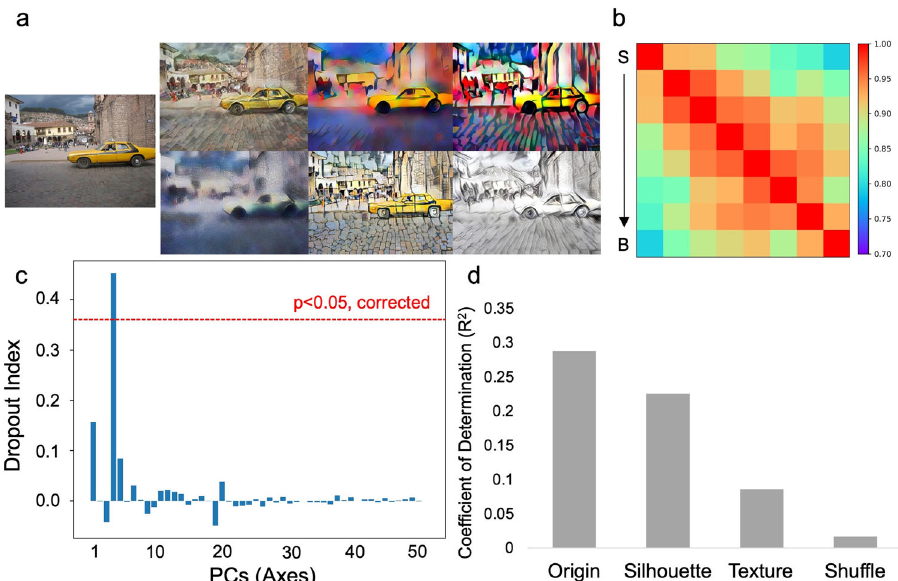
Fig. 7 The necessity of texture information in inferring objects ’ size in DCNNs. a Images from the ImageNet were transformed with various painting styles, where the shape information was preserved and the texture information distorted. b The RSM of Conv4 ’ s response to objects ’ size is similar to the ideal observer. c Only the fourth axis of object space constructed by the stylized AlexNet encoded the size feature. d Logarithm correspondence between PC4 and objects ’ size showed much less sensitivity to texture as compared to shape.